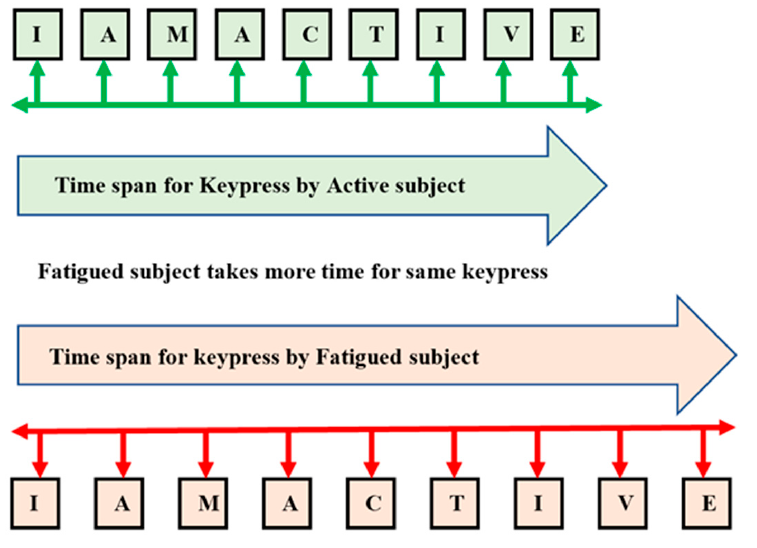
Figure 5. Active vs. fatigue keypress count.